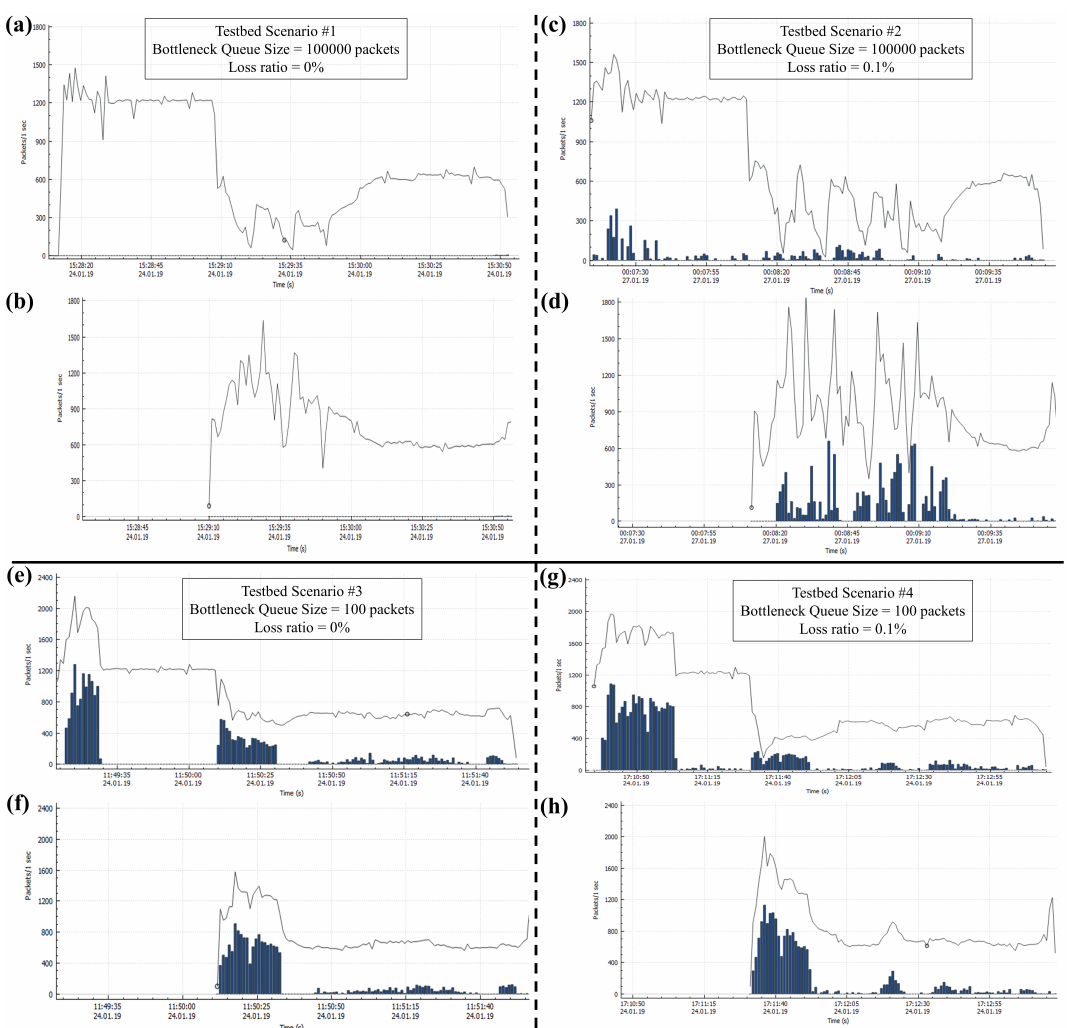
Figure 3. Comparison of input/output packets per second per sender for different testbed scenarios — ( a,b ) for Testbed Scenario #1, ( c,d ) for Testbed Scenario #2, ( e,f ) for Testbed Scenario #3, and ( g,h ) for Testbed Scenario #4. The bars indicate the lost number of